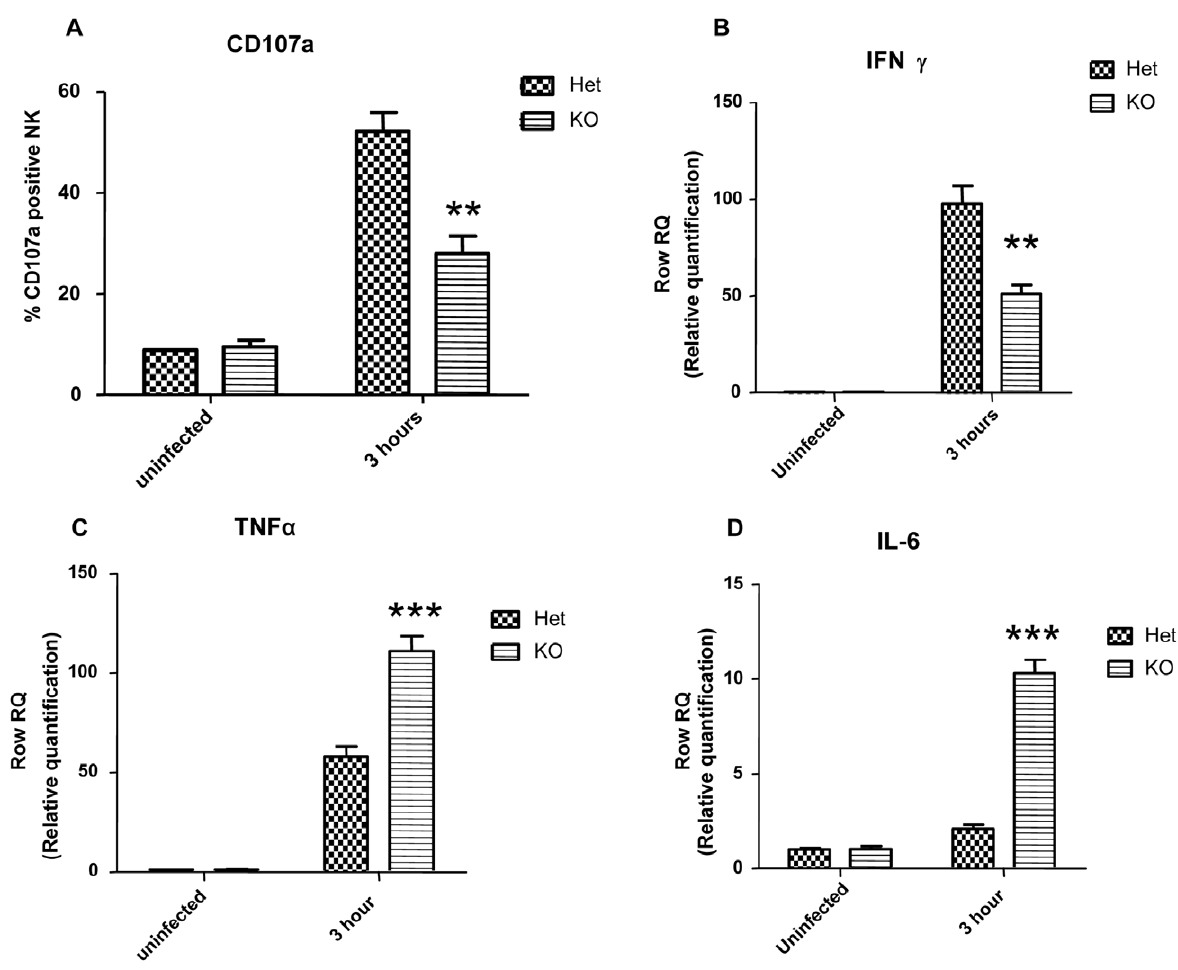
Figure 3. NK cells activation and cytokines mRNA levels in lungs following intranasal challenge with S.pneumoniae . Lungs were harvested from Ncr1 + /gfp (Het group) and Ncr1 gfp/gfp (KO group) C57BL/6 mice 3h after intranasal inoculation with 5 6 10 7 CFU of S. pneumoniae strain WU2, and from non infected mice. (A) NK cells were gated as CD45 + NK1.1 + and analyzed for the expression of membrane-associated CD107a by flow cytometry. The bar graphs show the fraction of CD107a positive NK cells (average of 3 mice per group, 6 SD). ** p , 0.01 compared to Het group in 3h-infected mice (ANOVA test). Total RNA was extracted from naı¨ve lungs and from 3h-infected lungs of Ncr1 + /gfp (Het) and Ncr1 gfp/gfp (KO). Infection was performed with 5 6 10 7 CFU of S . pneumoniae. Level of cytokines mRNA of IFN c (n=4), TNF a (n=4) and IL-6 (n=3) were analyzed by RT-PCR and calibrated to mRNA level of GAPDH. Results are from one representative experiment of two. *** p , 0.001, ** p , 0.01, compared with the Het group + SD (ANOVA